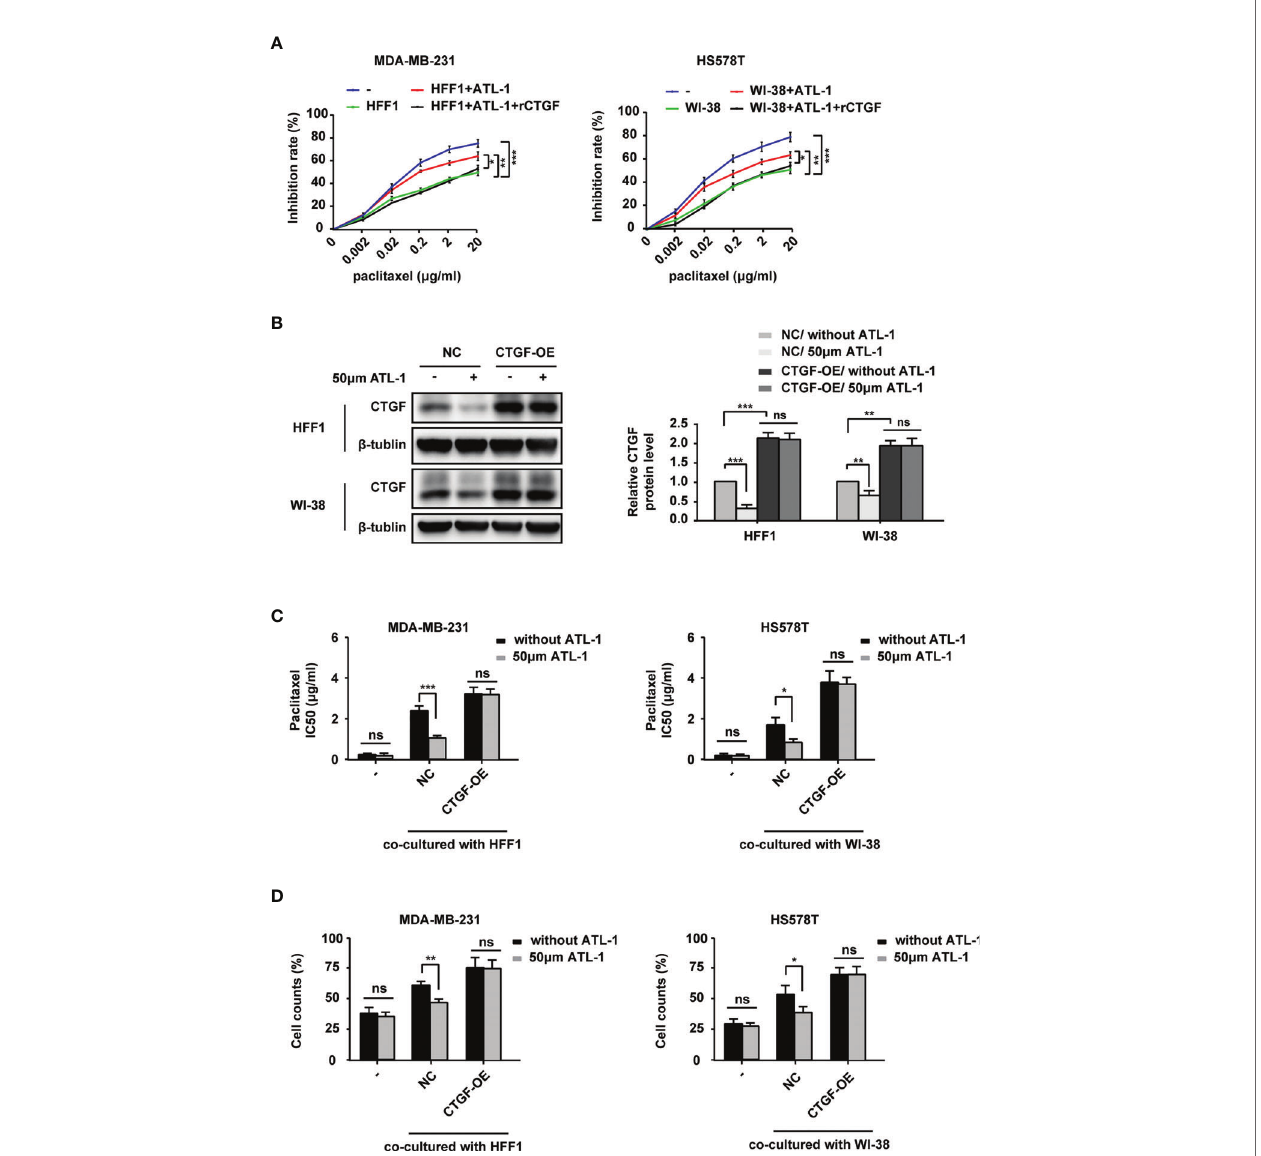
FIGURE 5 | ATL-1 increased the sensitivity of TNBC cells to paclitaxel by downregulating the expression of CTGF in fi broblasts. CCK8 (A) assay showed the growth-inhibiting effects of paclitaxel on MDA-MB-231 and HS578T cells cultured alone ( – ) or co-cultured with fi broblasts with or without ATL-1 treatment and rCTGF treatment for 48 hrs. (B) Western blotting demonstrated that CTGF expression was overexpressed in HFF1 and WI-38 cells. After being overexpressed, there was no difference in CTGF expression between with and without ATL-1 treatment. (C) CCK8 showed the IC50 of paclitaxel on MDA-MB-231 and HS578T cells cultured alone ( – ) or co-cultured with fi broblasts with or without ATL-1 treatment for 48 hrs. (D) Trypan blue exclusion assay showed the live cell counts after paclitaxel treatment on MDA-MB-231 and HS578T cells cultured alone( – ) or co-cultured with fi broblasts with or without 50 m M ATL-1 treatment for 48 hrs. ATL-1 increased the growth-inhibiting effects of paclitaxel in co-culture systems (NC), which was attenuated by the overexpression of CTGF in fi broblasts (CTGF-OE). (A – D) Three technical replicates were performed for each of the three biological replicates. Mean ± SD, *p < 0.05, **p < 0.01, ***p < 0.001 by Student ’ s t